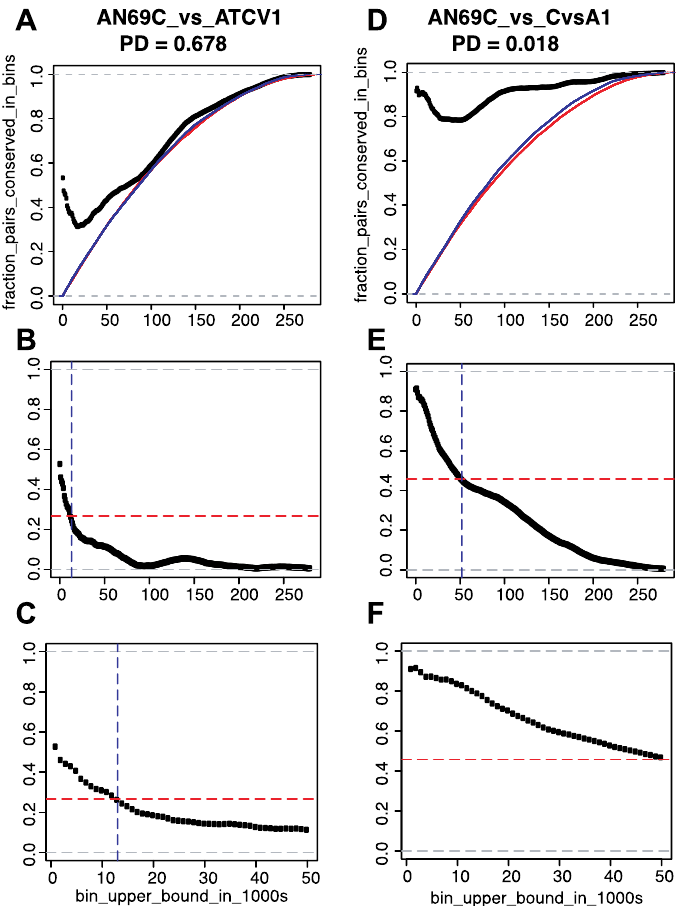
Figure 3. Analysis of pairwise conservation of SCCG distances in continuously increasing bin sizes. Representative analyses of two-genome comparisons of SCCG distance conservation in bins of growing size are presented. The distances between SCCGs in the genome of virus AN69C are compared against the genome of virus ATCV1 (large phylogenetic distance = 0.678) and those present in the virus CvsA1 (small phylogentic distance = 0.018). In all plots, the x -axes report the size of the bins considered in thousands of base pairs (e.g., point 1 represents a distance bin ranging from 0 to 1000 bp, point 5 represents a distance bin from 0 to 5000 bp, etc.). The y -axes in all plots represent the fraction of SCCG pairs whose distance is conserved within the same bin size in both genomes. Grey dashed lines represent upper and lower bounds of fractional conservation, 1 and 0, respectively. In ( A , D ) the y -axis reflects the calculated value of conservation arrived by direct comparison of the two genomes while in ( B , C , E , F ) the y -axis reports the degree of conservation minus the expected conservation based on a random gene shuffling model. ( A ) A direct comparison of SCCG distance conservation between viruses AN69C and ATCV1 (phylogenetic distance = 0.678) for bins of increasing size is depicted by the dotted black line. Models for expected conservation, based on a model of random shuffling derived from the respective cumulative distributions functions of pairwise gene distances in each genome, are drawn as red and blue lines for the first (AN69C) and second (ATCV1) genomes, respectively. Non-random conservation of pairwise distances appear as points above the random-shuffle models and approach the random model as bin sizes grow. ( B ) Plot of the data shown in ( A ) with the random model from the second genome subtracted. A horizontal dashed red line indicates the threshold of fractional conservation at which no “signal” of conservation can be reliably claimed if the random-shuffle model is applied. The vertical dashed blue line represents the intersection between black and red curves and represents the maximum bin size for which conservation of pairwise distances can be reliably reported. ( C ) A magnified portion of panel B. ( D – F ) The same analyses in ( A – C ) respectively, for the comparison of viruses AN69C and CvsA1 (phylogenetic distance =